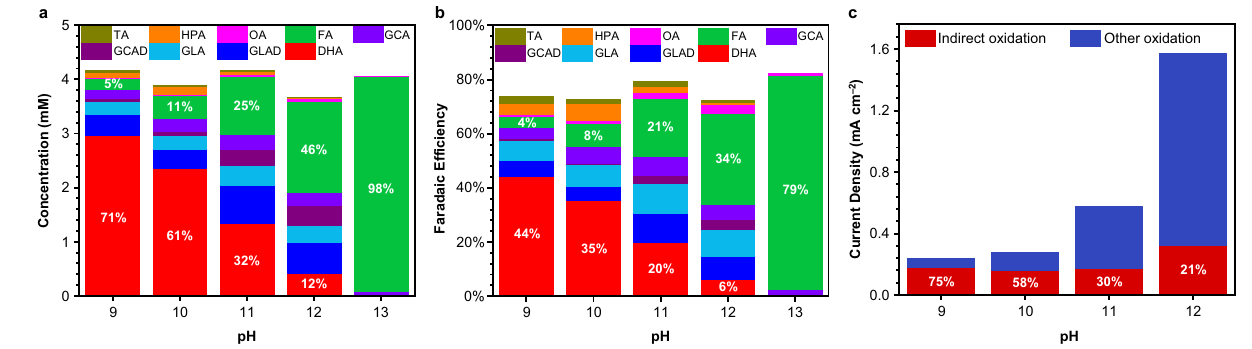
Fig. 4 | Glycerol oxidation results after electrolysis at a constant potential of 1.52 V RHE under various pH conditions. a Product distributions showing con- centrations after passing 18C (the stoichiometric charge needed to convert ~25% glycerol to DHA). The percentages in white indicate the relative selectivities for DHA (red) and FA (green). b Faradaic ef fi ciencies (FEs) after passing 18C. The percentages in white indicate the FEs for DHA (red) and FA (green). c Current